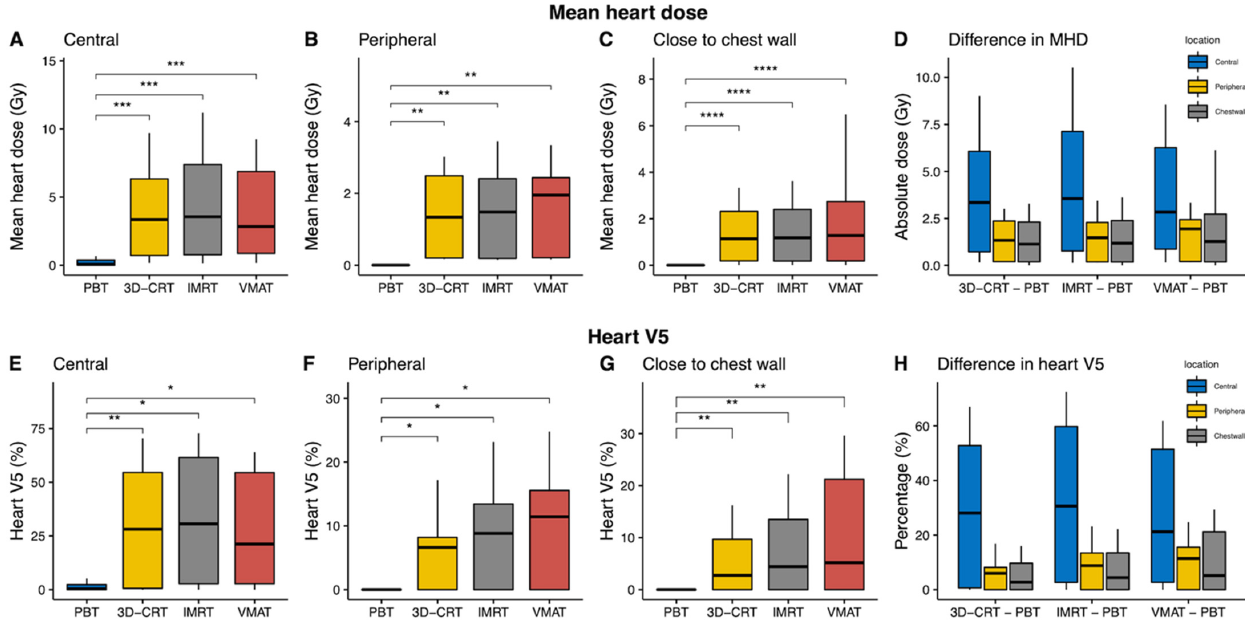
Figure 3. Mean heart dose (MHD) and heart V5 comparisons according to treatment modality and tumor location. We found that proton beam therapy (PBT) provided a statistically significantly reduced MHD and V5 as compared to the other photon-based radiotherapy techniques at each location. ( A – C ) Boxplots of the MHD are shown in units of absolute dose per location. ( D ) Boxplots of the median differences in the MHD between photon-based radiotherapy techniques and PBT. ( E – G ) Boxplots of the percentage of the heart receiving 5 Gy in each subgroup. ( H ) Median differences in the heart V5 between photon-based radiotherapies and PBT. * p ≤ 0.05; ** p ≤ 0.01; *** p ≤ 0.001; **** p ≤ 0.0001.